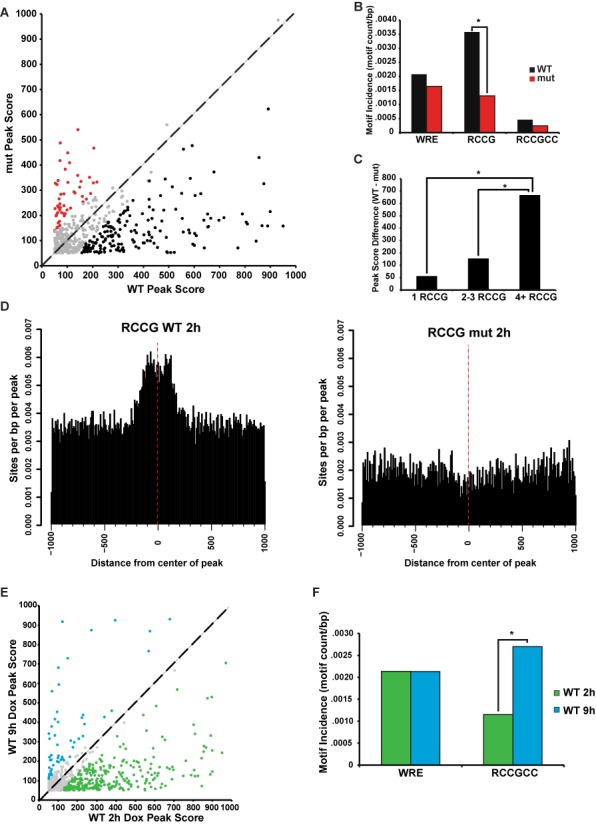
The C-clamp-Helper site interaction contributes to overall DNA binding strength. (A) Scatter plot displaying the peak scores associated with genomic regions bound by both dnTCF1EWT and dnTCF1Emut at 2 h post-induction (any overlap). dnTCF1EWT peak scores were significantly higher than dnTCF1Emut peak scores (Wilcoxon–Mann–Whitney test, P = 3.5E-10). Regions bound more strongly by dnTCF1EWT (black), dnTCF1Emut (red) and similarly enriched (gray) are indicated. (B) The short Helper site (5′-RCCG-3′) is significantly enriched in peaks bound more strongly by dnTCF1EWT (Wilcoxon–Mann–Whitney test, P = 1.3E-5), whereas the WRE is not significantly enriched in regions bound more strongly by dnTCF1EWT and dnTCF1Emut (P = .10). There were very few Helper sites (5′-RCCGCC’-3) bound by dnTCF1Emut and therefore a significant difference between peaks more strongly bound by wild-type and mutant was not seen (P = 0.97). (C) Increased copy number of the short Helper site is associated with greater differences in peak scores between dnTCF1EWT and dnTCF1Emut (1 RCCG compared to 4+ RCCG: P = 1.0E-7, 2–3 RCCG compared to 4+RCCG: P = 8.0E-6). (D) Histogram showing that the short Helper site is enriched near the center of dnTCF1EWT but not dnTCF1Emut peaks. (E) Scatter plot displaying peak scores associated with genomic regions bound by dnTCF1EWT at both 2 and 9 h of induction. Peak scores were significantly higher for dnTCF1EWT at 2 h post-induction (Wilcoxon–Mann–Whitney, P = 1.7E-15). (F) Regions bound more strongly by dnTCF1EWT at 9 h have an enrichment of the Helper site (P = 0.0008), but not the WRE (Wilcoxon–Mann–Whitney test, P = 0.97).